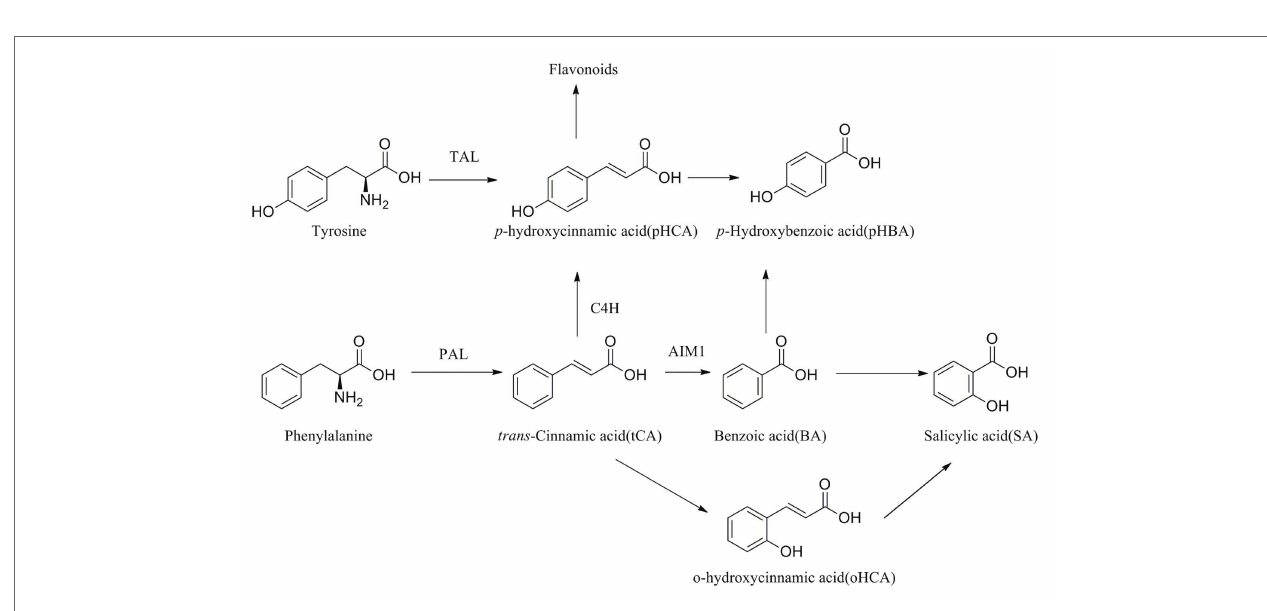
FIGURE 8 | Quantitative analysis of concentrations of SA and SA-related phenolics in larch adelgids, gall tissues, and P. koraiensis cones. Quantitative analysis of salicylic acid (SA), benzoic acid (BA), p -hydroxybenzoic acid ( p HBA), p -hydroxycinnamic acid ( p HCA), and trans -cinnamic acid ( t CA) in gall tissues and normal branches (A,C,E,G,I) and cones (B,D,F,H,J), respectively. CK = normal branches. Data are presented in nanograms per gram of fresh weight (ng/g FW), and boxplots display the minimum, first quartile, median, third quartile, and maximum for each stage in the given tissues. Red point = mean value and horizontal black line inside the box = median value. Shape of boxplots indicates distribution of results. The mean differences were compared using t -tests. * indicates that the value of p is less than 0.05. ** Indicates that the value of p is less than 0.01. *** Indicates that the value of p is less than 0.001. The results shown are an average ± SD and performed one-way ANOVA test among three or more groups. ω p 2 = partial omega